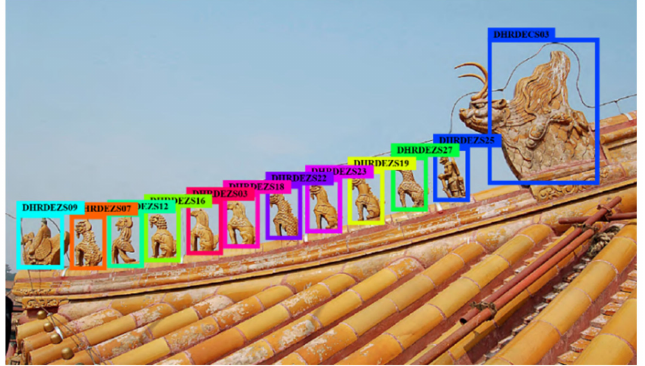
Figure 6. Detection results of decorative components (The Hall of Supreme Harmony)